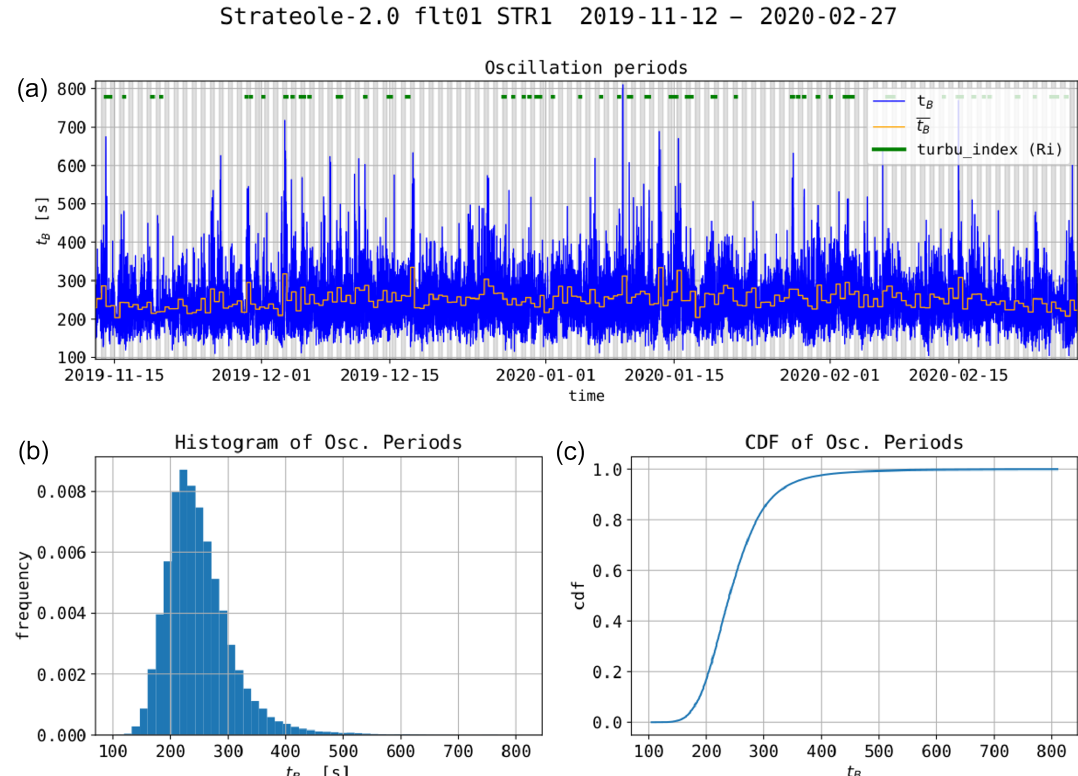
Figure 3. (a) Estimates of the SPB oscillation periods during flight 01_STR1; the orange staircase curve shows daytime and nighttime averages. (b) Histogram of the oscillation periods. (c) Cumulative distribution function of the oscillation